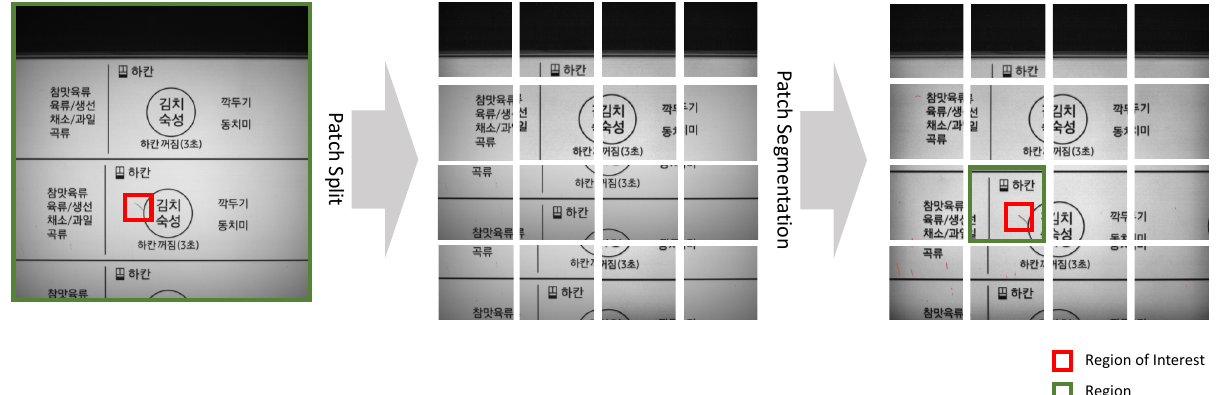
Figure 9. Proposed detailed inference method.